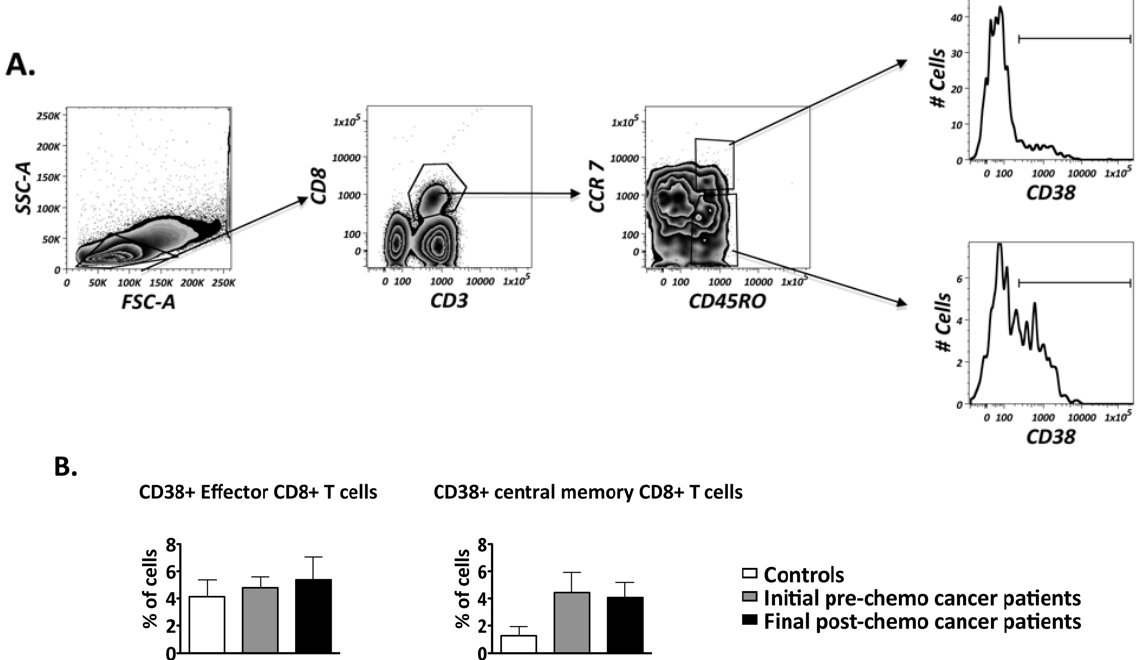
Figure 3. Frequency of recently activated CD8+ T cell subsets present within the PBMCs of patients during the course of chemotherapy. Flow cytometry was performed on PBMCS isolated from controls (n = 6) and patients undergoing chemotherapy (n = 5). ( A ) The gating strategy employed to identify recently activated effector and central memory CD8+ T cells present within the PBMCs; ( B ) Comparison of the CD8+ T cell subsets between controls and patients: pre-chemo representing 0 rounds while post-chemo represents 6 rounds of chemotherapy; ( C ) Frequency fluctuations of CD8+ T cell subsets of patients over the course of chemotherapy. The dotted line represents the mean frequency of the healthy controls. Comparison of CD8+ T cell subset frequencies between controls and patients: not